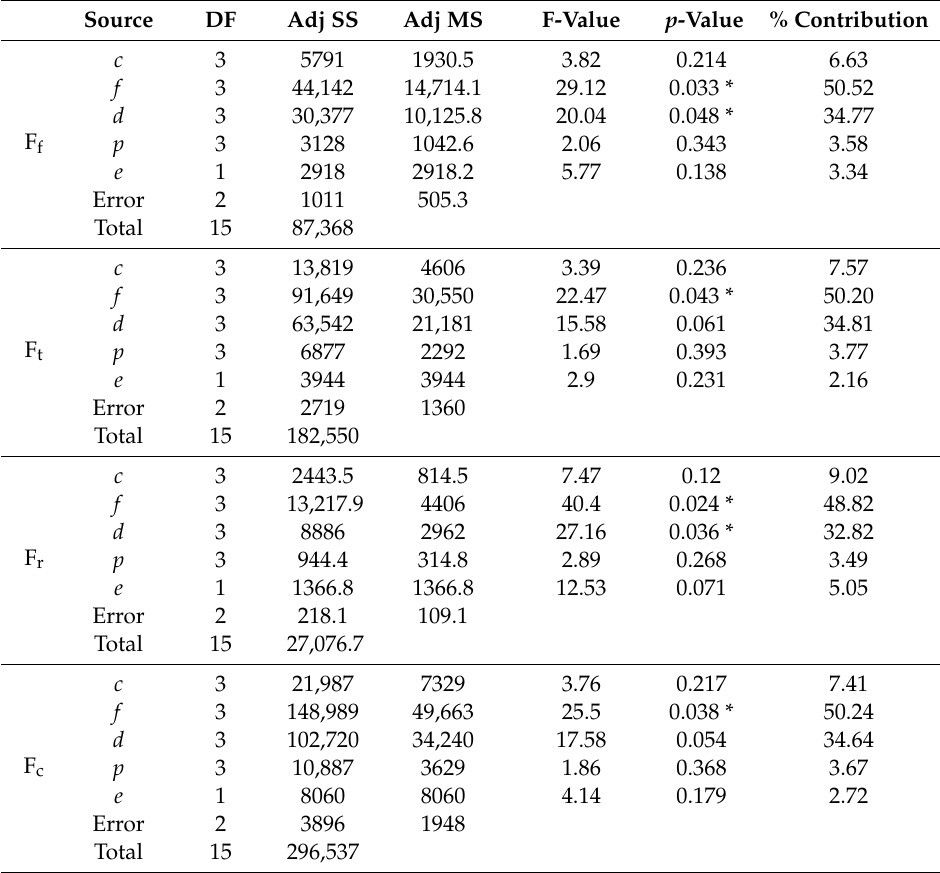
Table 3. Analysis of variance for components of cutting forces.